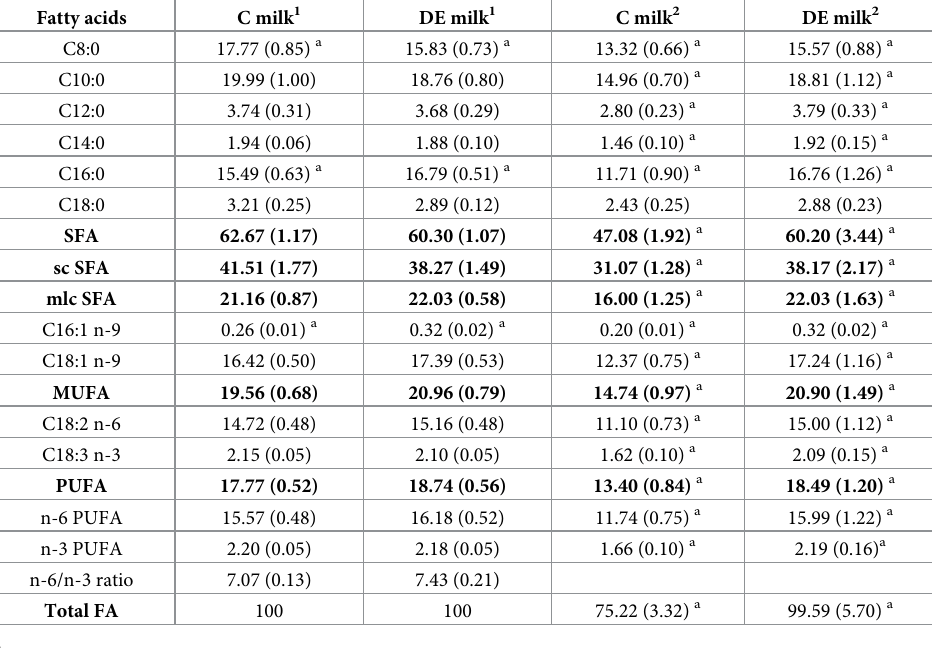
Table 1. Fatty acid composition and content in milk from control (C) and DE-exposed (DE) dams on days 2–4 of lactation. Fatty